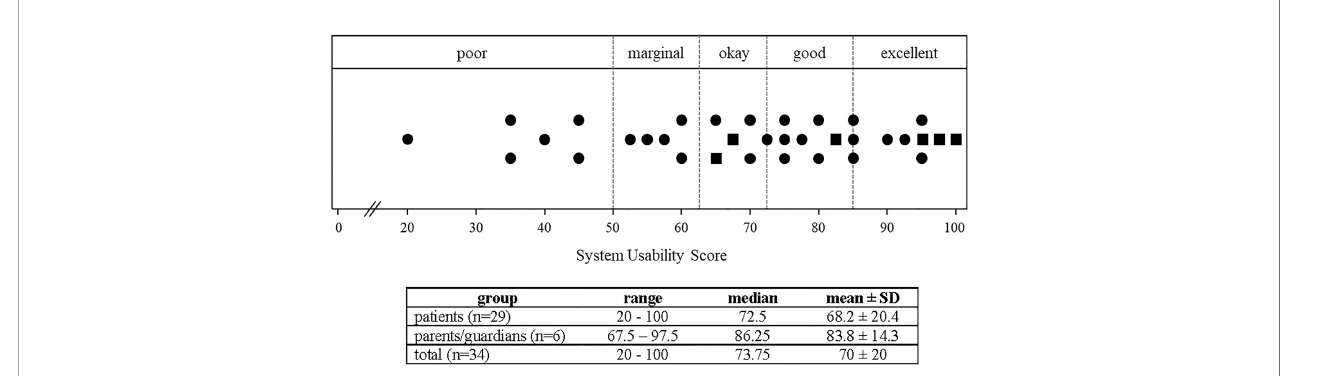
FIGURE 1 | System Usability Scale (SUS) ratings of the KS transition Passport (n=34). Individual SUS ratings are shown for patients (circles) and parents/guardians (squares). Cutoffs are depicted by dotted lines. The table reports descriptive statistics of patient, parent/guardian and total ratings. Patient and parent/guardian SUS scores did not differ (p=0.094).